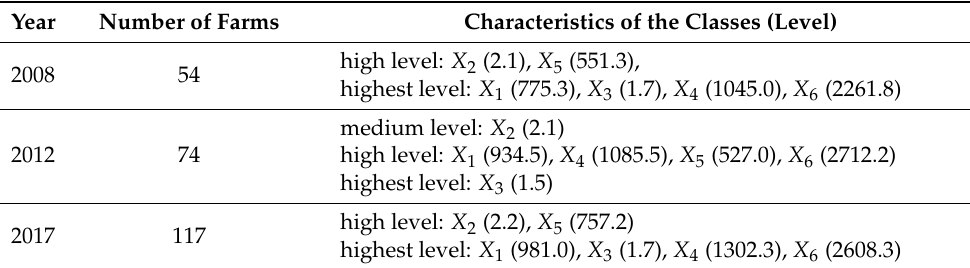
Table 7. Characteristics of farms in the type four